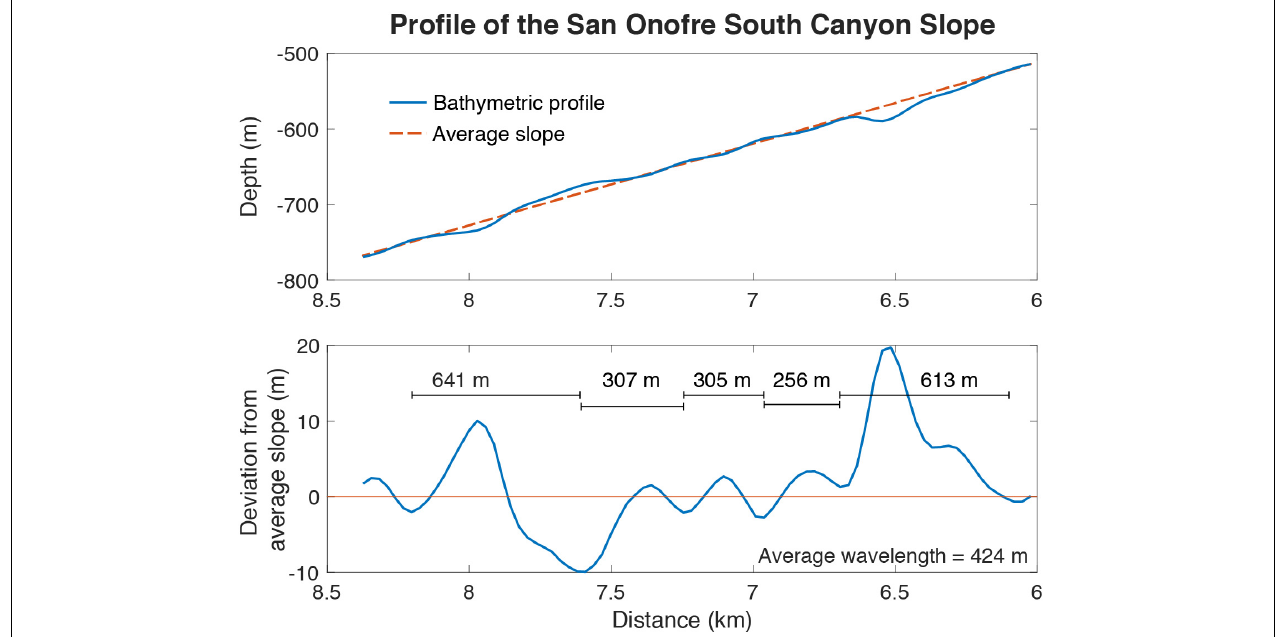
FIGURE 3 | (Top) The bathymetric profile from the lower slope of the San Onofre South Canyon is plotted in blue and has undulatory features. The dashed orange line is the average slope for this length of the canyon. (Bottom) Subtracting the average slope from the bathymetric profile reveals undulatory features with amplitudes ranging from 2 to 15 m and wavelengths ranging from 256 to 641